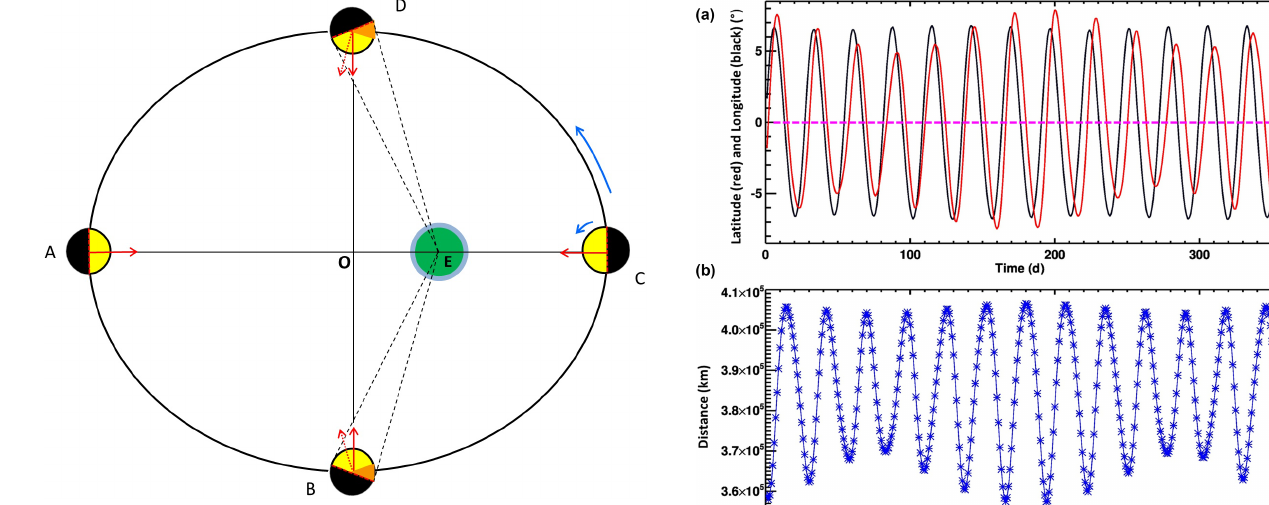
Figure 4. Libration in longitude results from the eccentricity of the Moon’s orbit. It can reach 7.9 ◦ in amplitude. Point A is the apogee of the lunar orbit (AE = r max ); point C is the perigee (EC = r min ); Figure 5. Variability of the Moon’s orientation and orbit during AO = a ; OE = ae ; points B and D are co-vertices; the semi-minor 2022, starting from 1 January 2022 (Espenak, 2021). The distance (cid:112) 1 − e 2 . Additional areas of the lunar surface axis OB = OD = a between the Earth and the Moon is measured between the centers that become available for observation are marked in orange. View of the bodies, so it does not depend on libration, which is mea- from the North Pole of the Earth. sured in angles relative to the centers of the bodies. (a) Longitude libration (red) and latitude libration (black). The straight dashed line corresponds to the case of zero libration – that is, when the center of the visible lunar disk coincides with the zero point of seleno- graphic longitude and latitude. (b) The Earth–Moon distance. The time-averaged distance between the centers of Earth and the Moon is 385000km; the minimal distance is 356500km, and the maximal distance is